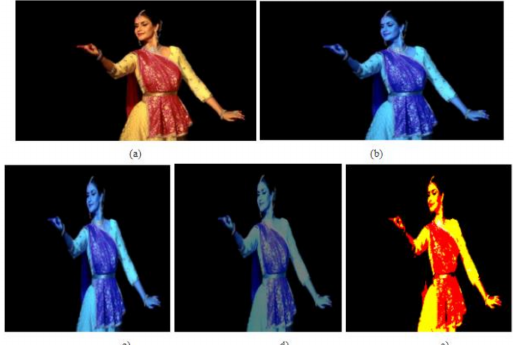
Figure 3. ( a ) Original image, ( b ) RGB to BGR, ( c ) resized image, ( d ) threshold image ( e ) sampled